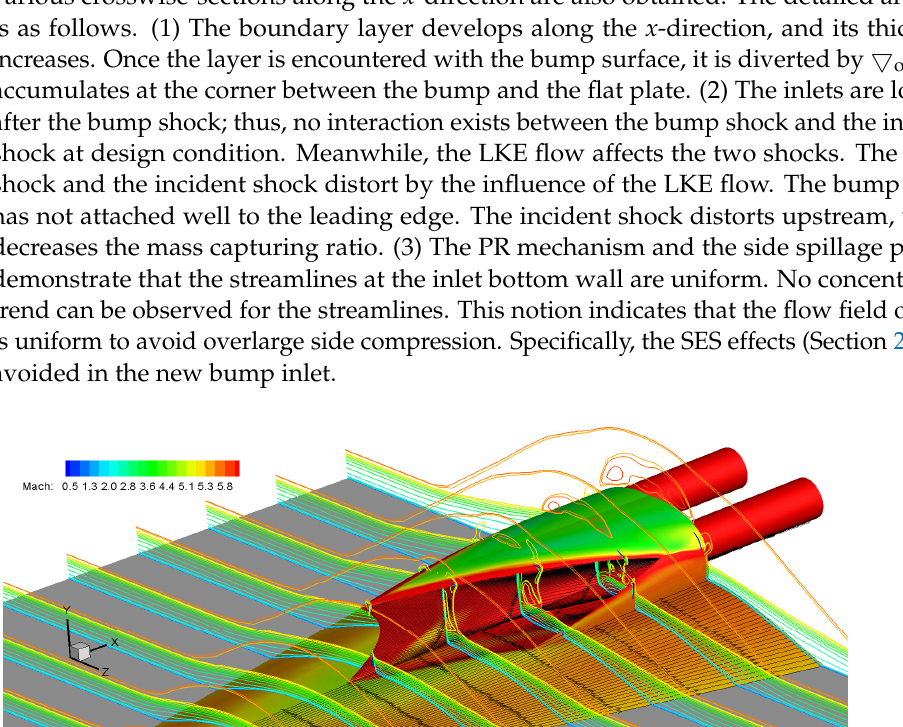
Table 3. Start ‐ ability of the spillage ‐ adaptive inlet. M ∞